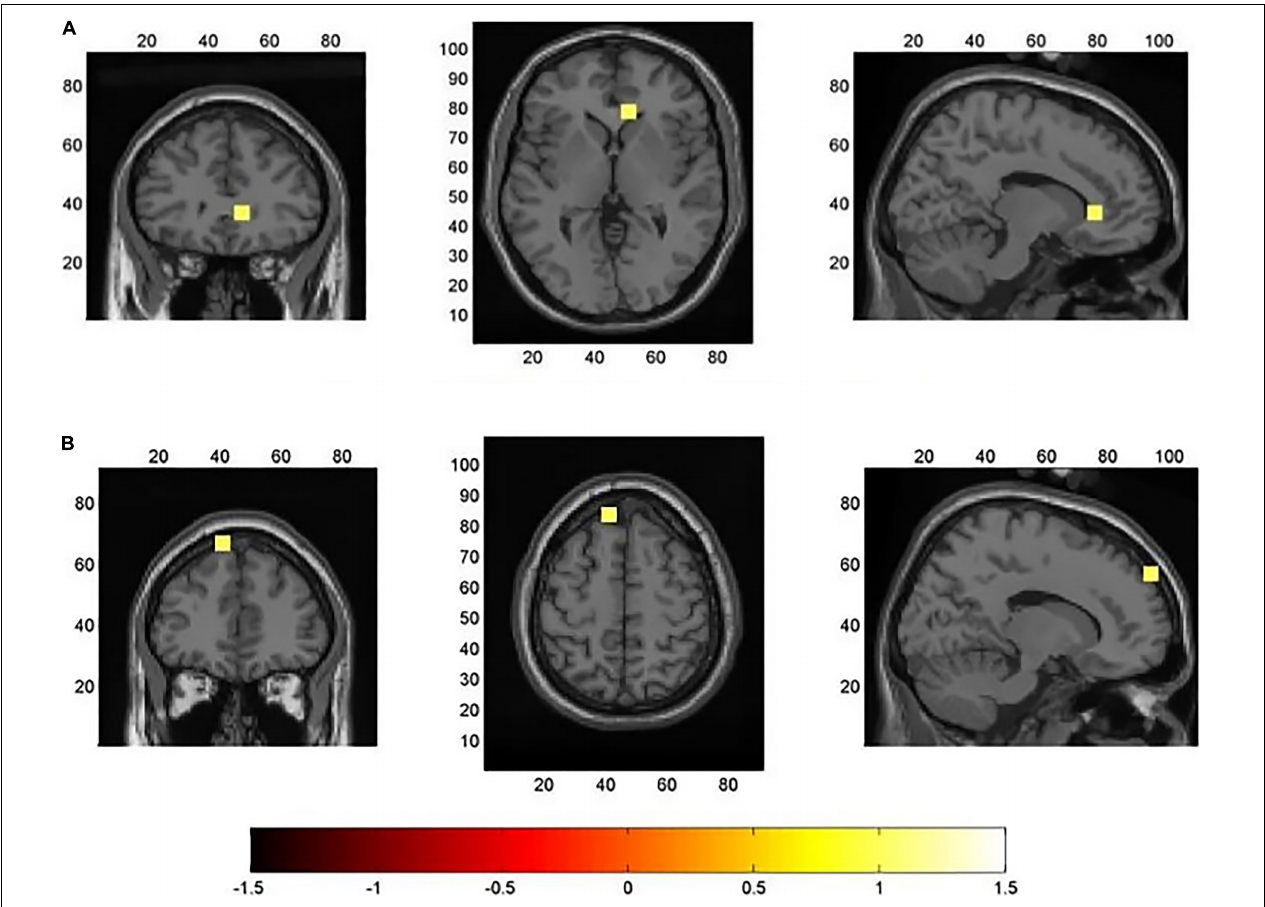
FIGURE 5 | Results of minimum norm estimate (MNE) source analysis in the time window of the slow-wave potentials. (A) Source localization result from 600 to 700 ms. (B) Source localization result from 700 to 1,000 ms. The images represent the voxels in which the “high > low easy of learning (EOL) judgment” contrast was significant ( p < 0.05), and they have been corrected using a cluster permutation test. The significantly activated voxels are indicated by yellow